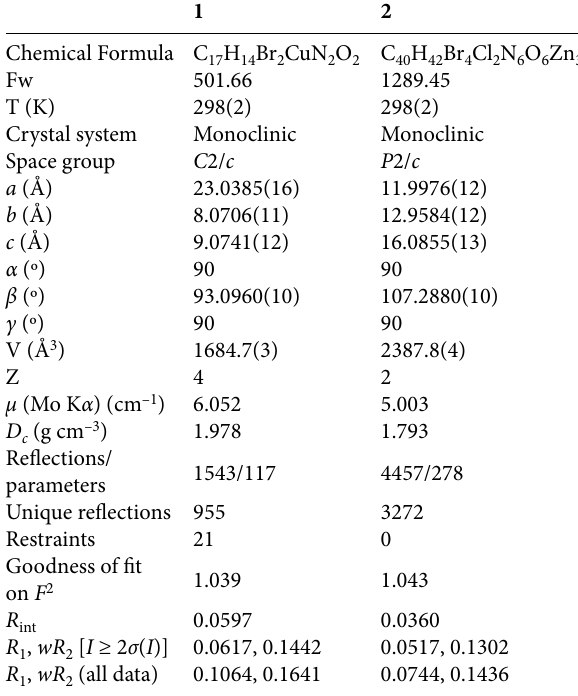
Table 1. Crystallographic data and refinement parameters for the